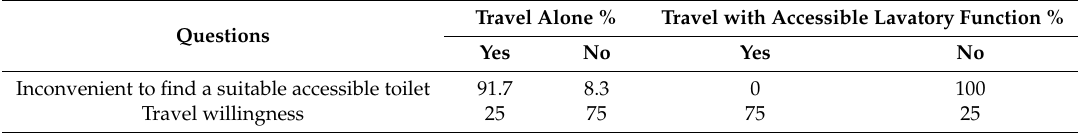
Table 6. Intention to travel.